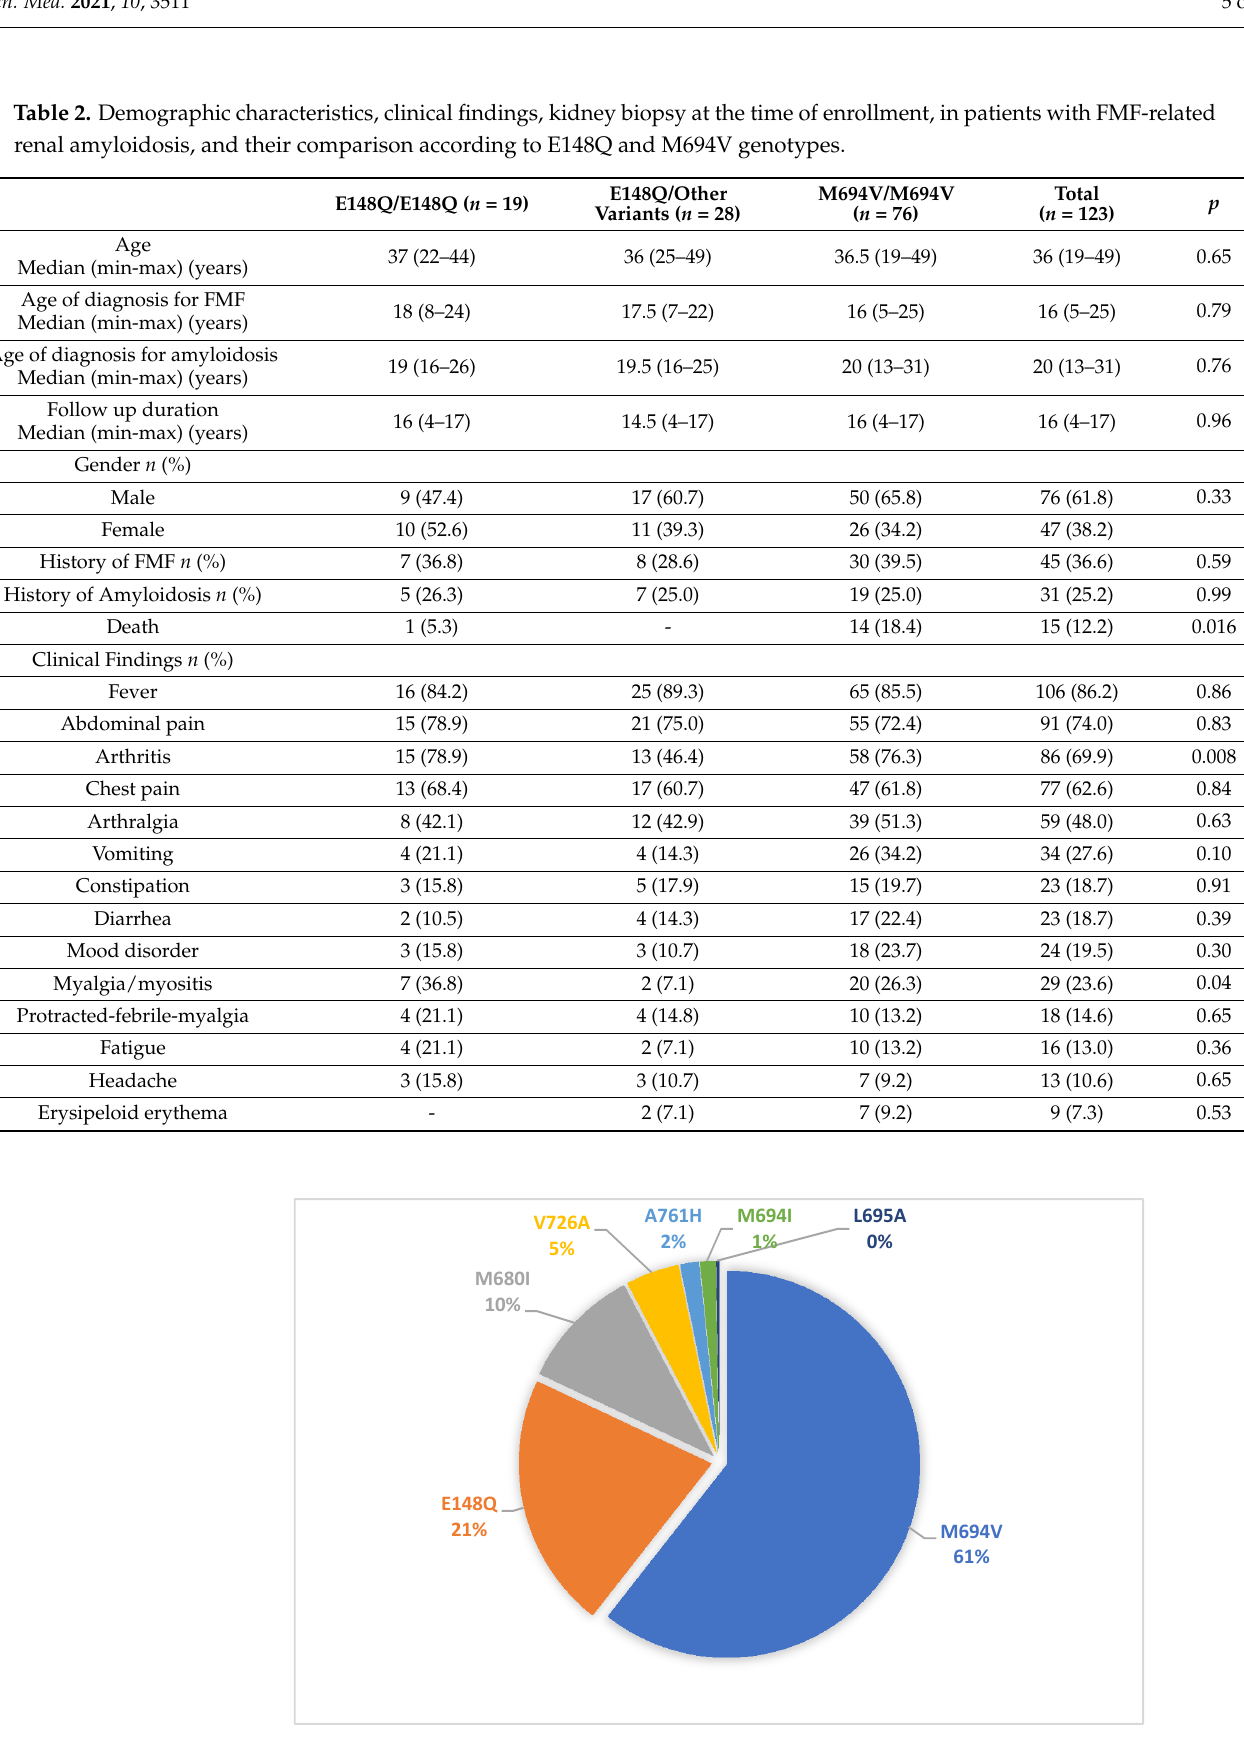
Figure 1. Allele frequencies in MEFV gene in patients with familial Mediterranean fever (FMF)- related renal amyloidosis.